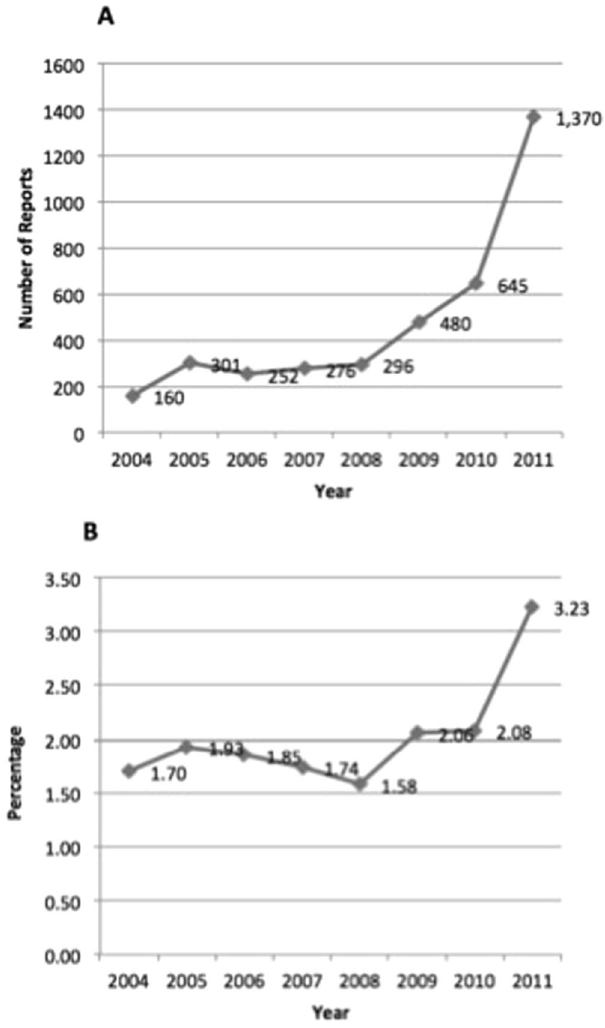
Figure 1. Increasing trend of proton pump inhibitor (PPI)-fracture reports from 2004 to 2011. ( A ) Reports of PPI with fractures. ( B ) Percentage of PPI-fracture reports among all PPI-AEs